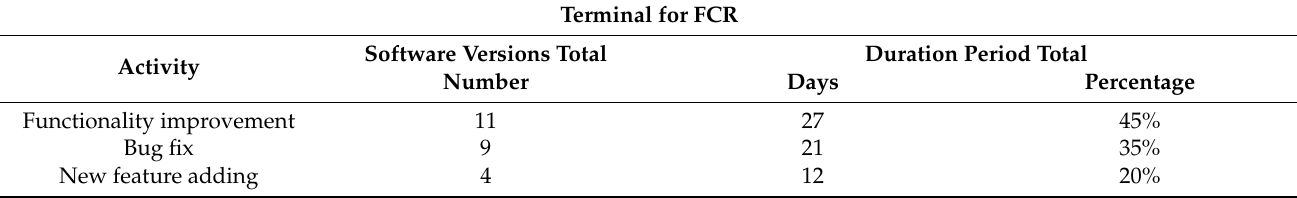
Table 3. The results of applying model-driven development method to the terminal for remote control of fiscal cash registers in the maintenance period in